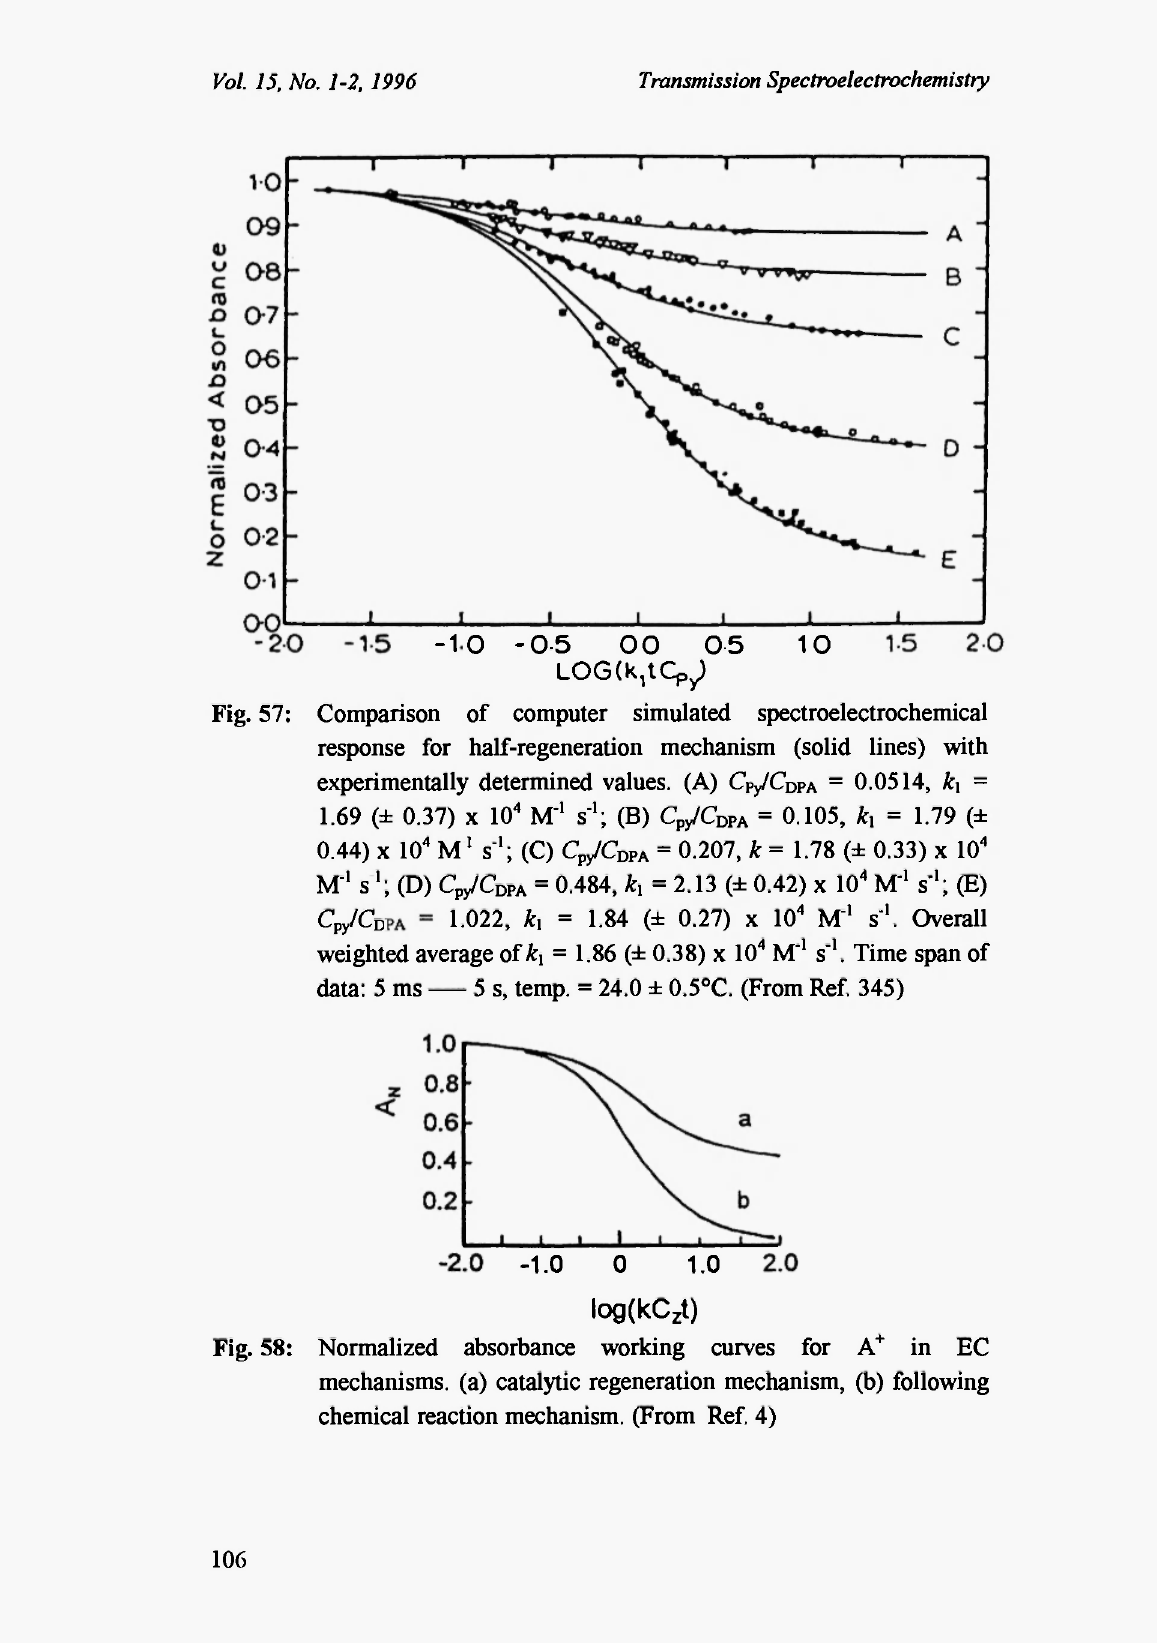
Fig. 58: Normalized absorbance working curves for A + in EC mechanisms, (a) catalytic regeneration mechanism, (b) following chemical reaction mechanism. (From Ref.